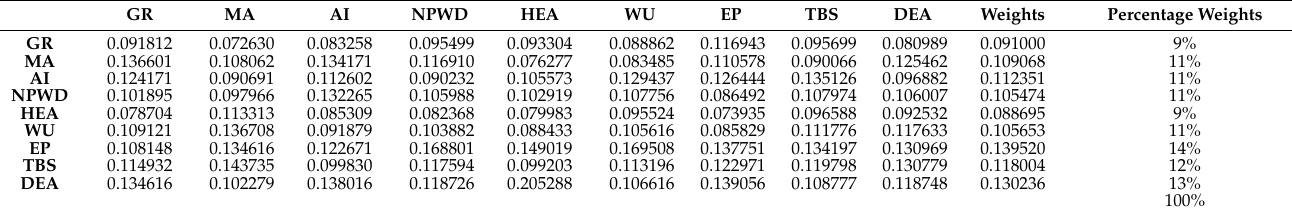
Table 2. Standard matrix for hazard parameters.